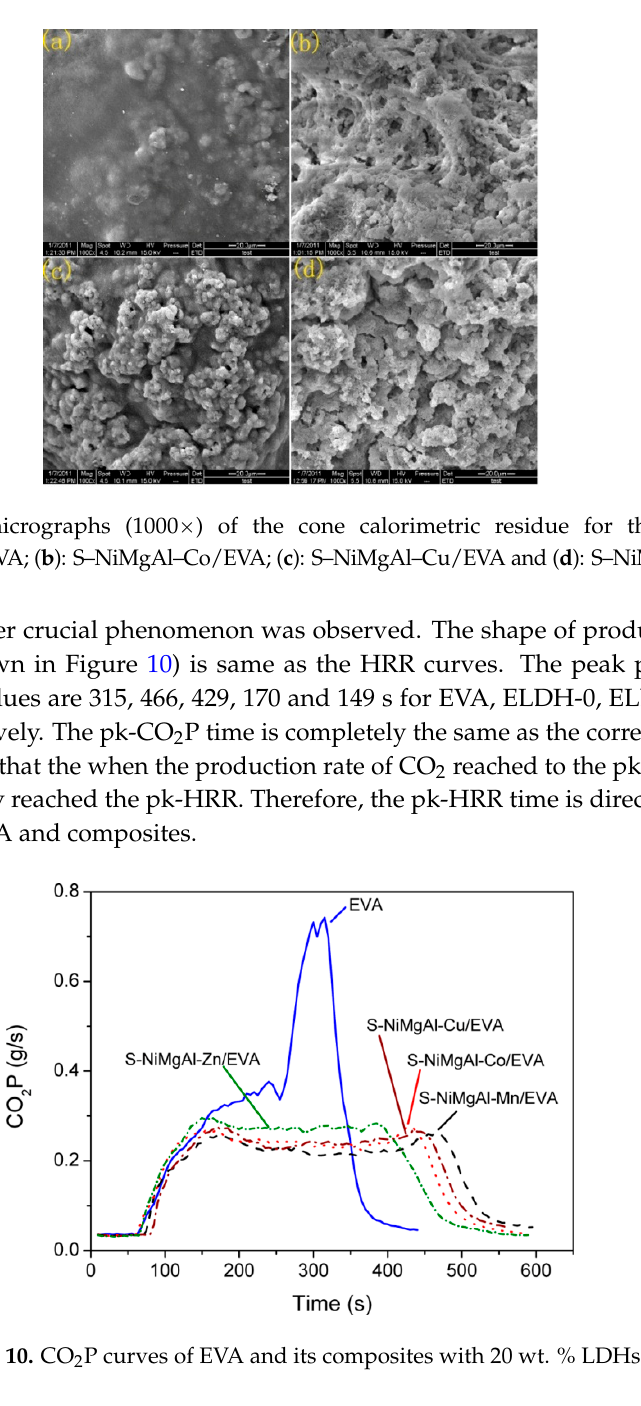
Figure 8. SEM images (1000×) of fractured surfaces for all the composites with 20 wt. % LDH. ( a ) S–